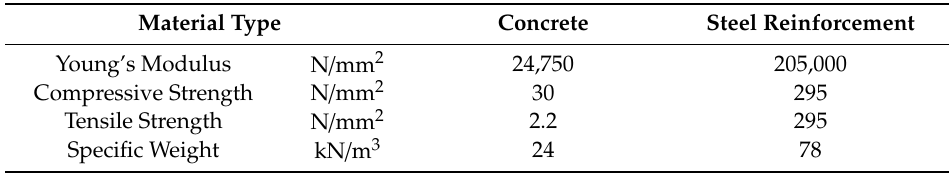
Table 1. Material properties of the referential slab.